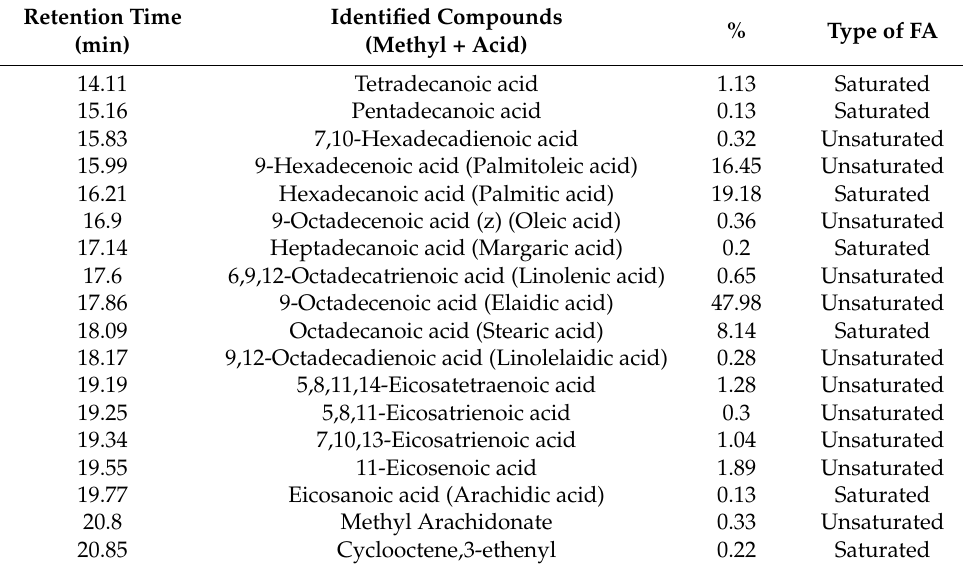
Table 5. FAME composition of chicken feet oil biodiesel.